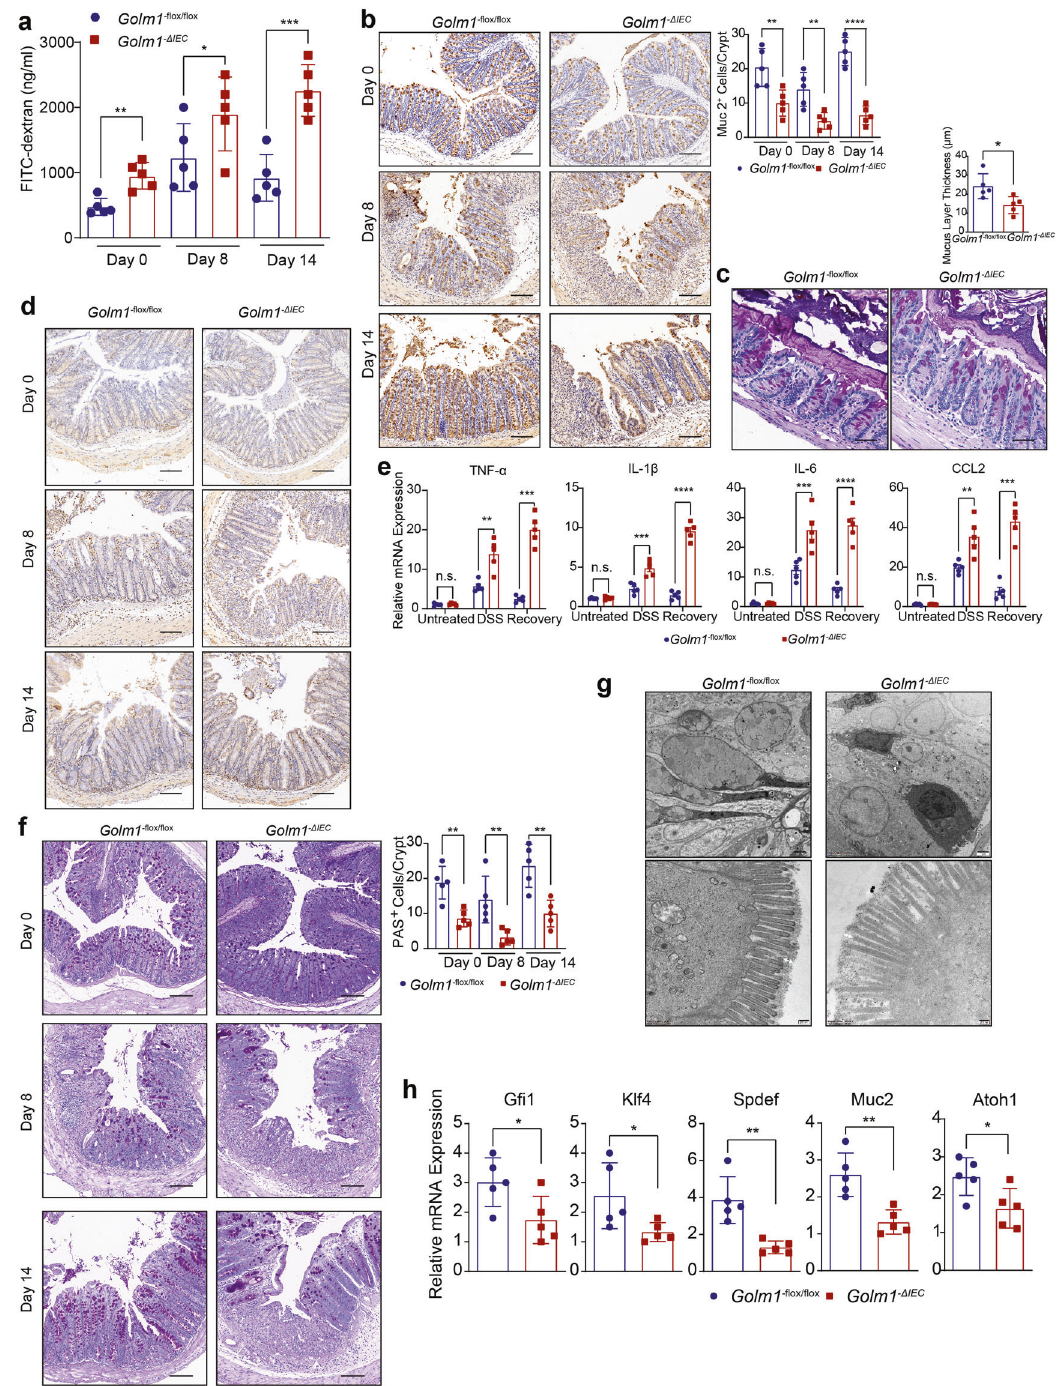
Fig. 3 GOLM1 de fi ciency in IEC increases mouse susceptibility of colitis and CAC. a The body weights of 2% DSS-treated Golm1 − Δ IEC mice and Golm1 − fl ox/ fl ox counterparts were recorded on indicated days (the data are represented as the means ± SEM, n = 5; * P < 0.05). b The disease activity indexes of Golm1 − Δ IEC mice and Golm1 − fl ox/ fl ox counterparts administered 2% DSS for 5 days (the data are represented as the means ± SEM, n = 5; * P < 0.05, ** P < 0.01, *** P < 0.001). c Representative image of colons obtained from Golm1 − Δ IEC mice and Golm1 − fl ox/ fl ox counterparts treated with 2% DSS for 5 days and sacri fi ced on day 8. d Representative H&E staining of mouse colon sections obtained from DSS-treated mice on the indicated days. Scale bars, 100 μ m. e Representative Ki67 staining of colon sections from mice treated with 2% DSS and sacri fi ced on the indicated days. Scale bars, 100 μ m. Quanti fi cation is shown in the histogram (the data are represented as the means ± SEM, n = 5; * P < 0.05; unpaired, two-tailed Student ’ s t test). f Representative images of colon tumors obtained from AOM/DSS-treated mice. g Representative H&E staining of mouse colon sections obtained from AOM/DSS-treated mice. Upper scale bars, 500 μ m; lower scale bars, 50 μ m. Percentages of mice with dysplasia at 70 days after injection of AOM. h Representative image of the spleens obtained from AOM/DSS-treated mice